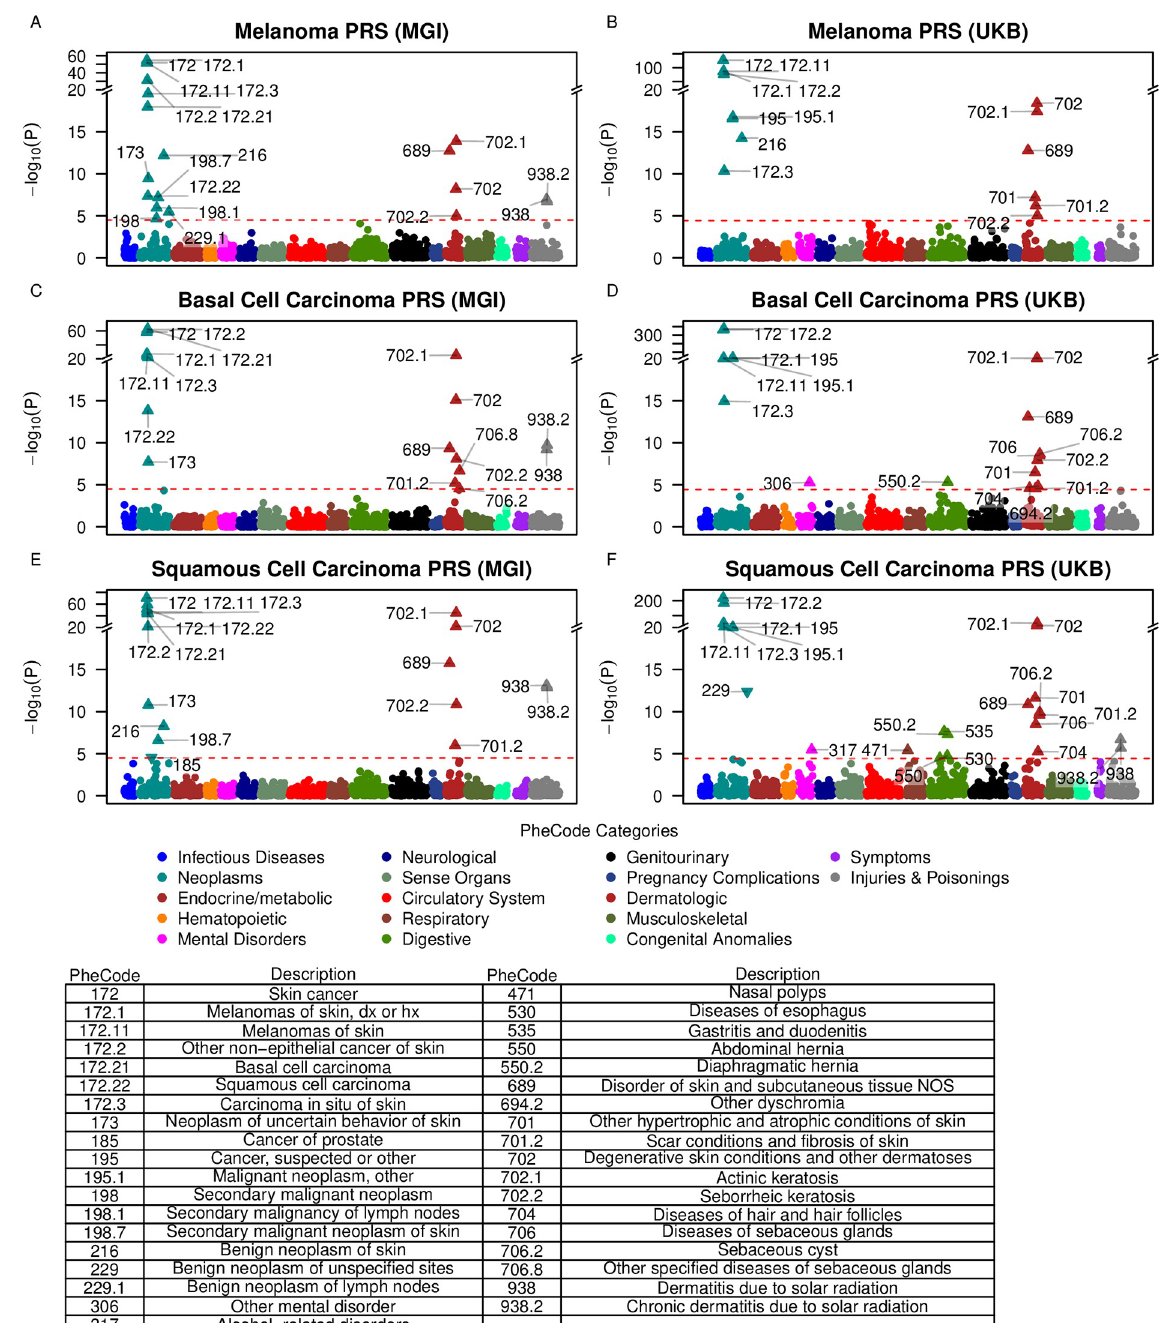
Fig 1. PRS-PheWAS in MGI and UKB phenomes. The horizontal line indicates phenome-wide significance. Phenome-wide significant traits are indicated by PheCodes with their description listed below. Directional triangles indicate whether a phenome-wide significant trait was positively (pointing up) or negatively (pointing down) associated with the